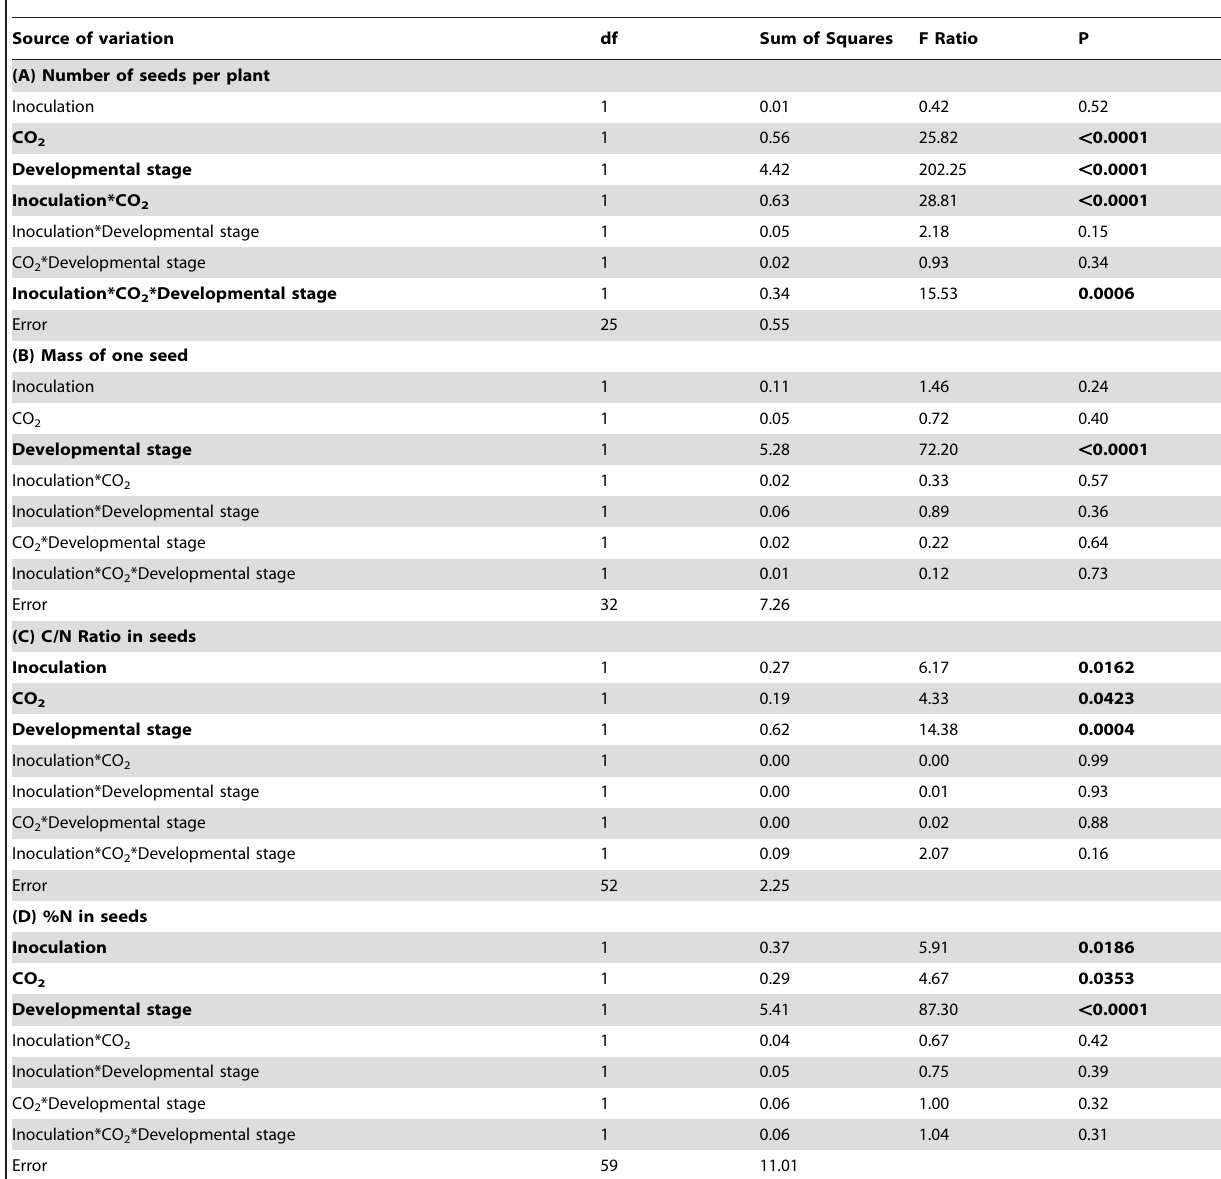
Table 5. Linear models explaining the quantitative (A) and qualitative (B,C,D) aspects of seeds of Medicago truncatula as a function of inoculation conditions (inoculated or not with Pseudomonas fluorescens C7R12), CO 2 concentration (ambient, 365 ppm or enriched, 750 ppm) and the plant developmental stage (Fp and Pf, see text).